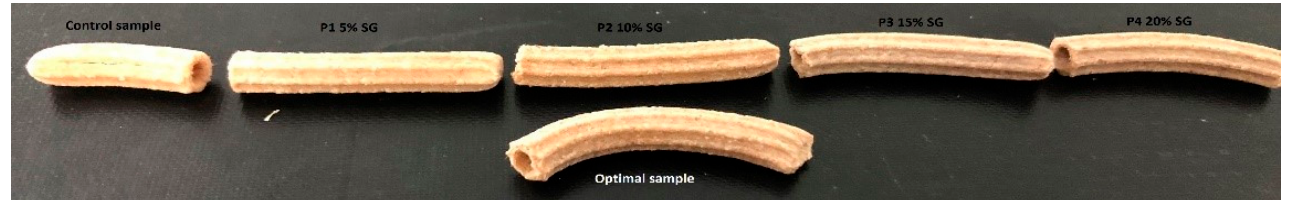
Figure 1. Effect of spent grain on ( A ) dough cohesiveness, ( B ) firmness of pasta dough, ( C ) pasta color, ( D ) pasta fracturability, ( E ) protein content, ( F ) total dietary fiber content, ( G ) total phenolic content, ( H ) antioxidant activity of pasta, and ( I ) pasta cooking loss.